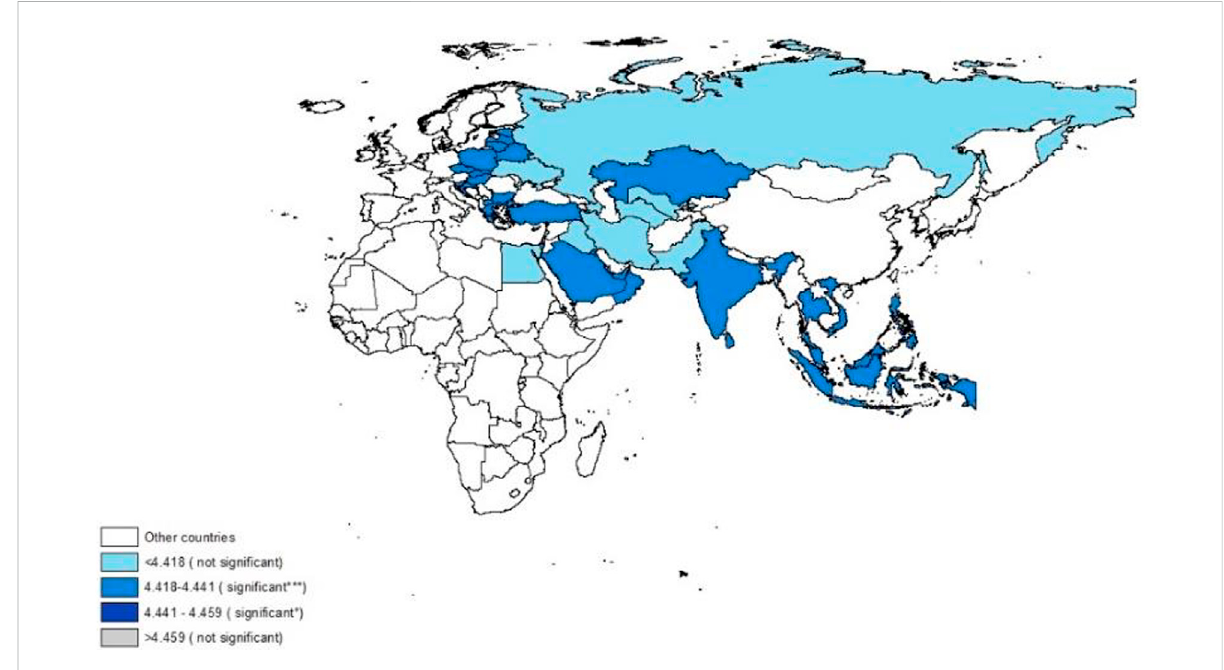
FIGURE 8 Signi fi cance distribution (institutional quality as threshold index).